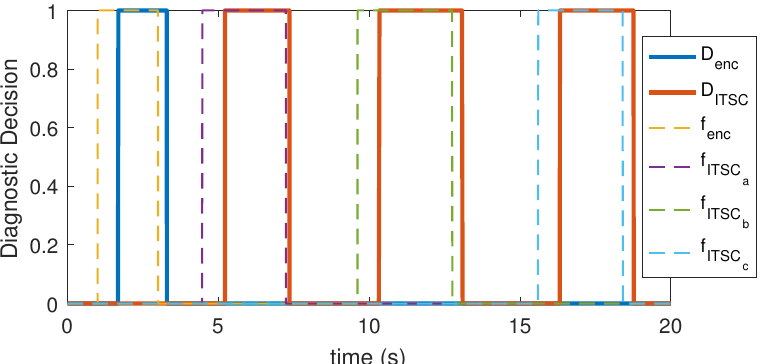
Figure 15. Timing of actual faults ( f enc , f ITSC ( D enc , D ITSC